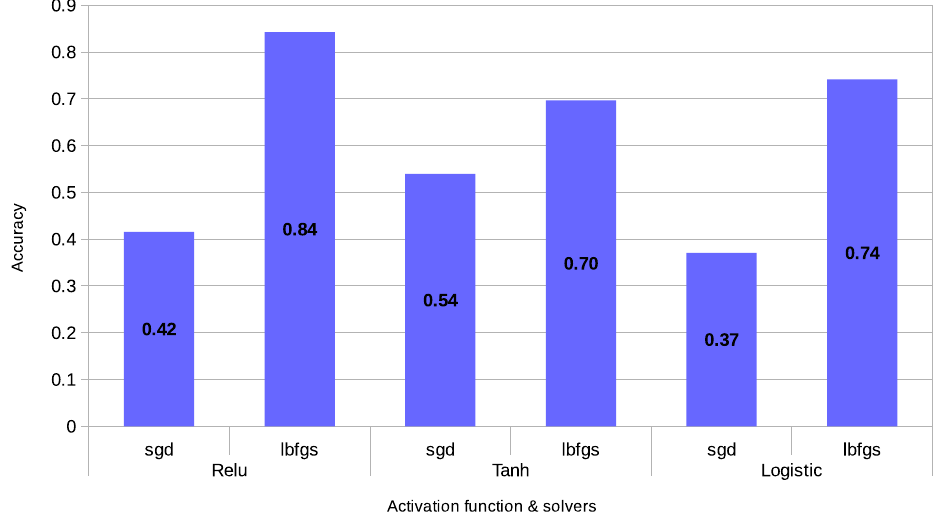
Figure 10. Classification model for dual method—tuning the number of hidden layers and neurons ( relu activation function, lbfgs solver).